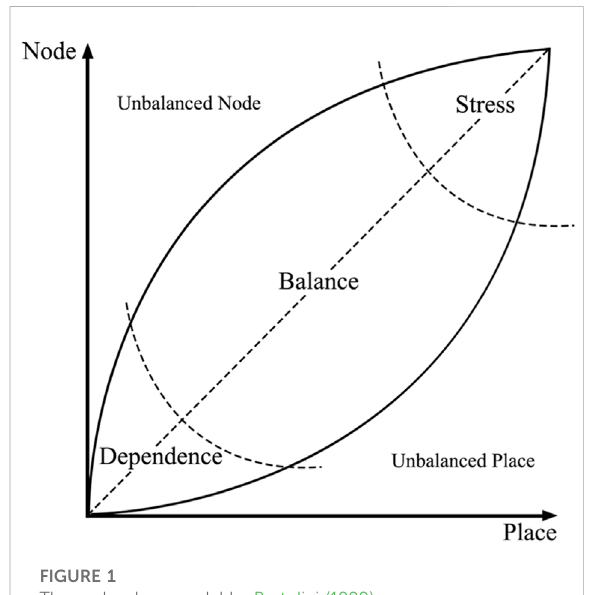
FIGURE 1 The node-place model by Bertolini